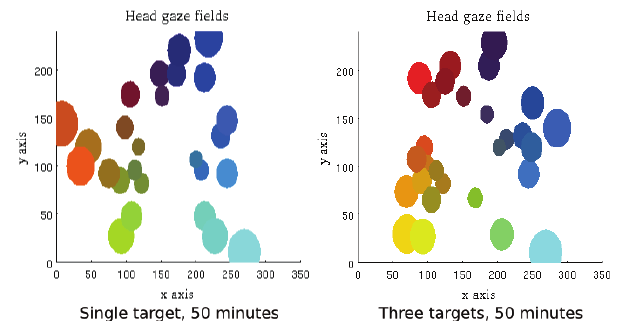
Figure 11. Head gaze maps after learning for 10 minutes of eye only learning, followed by 50 minutes of learning with both eye and head systems enabled. Left: single target scenario, Right: three targets scenario